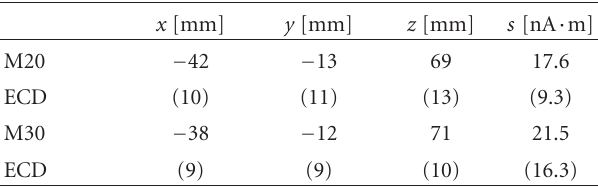
Table 2: M20 and M30 ECD positions and strengths.